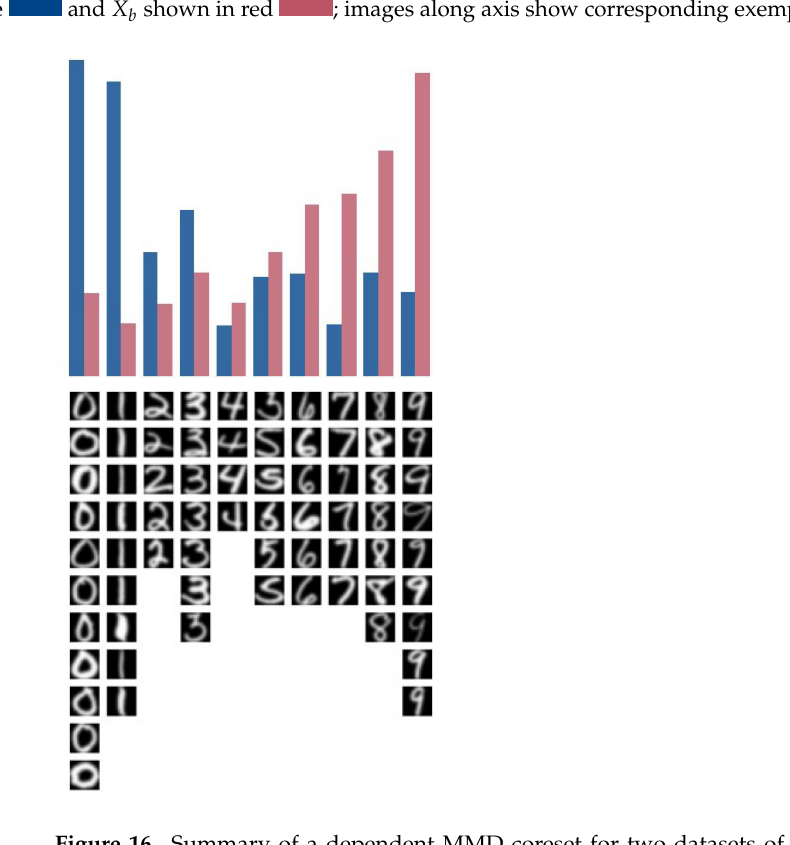
Figure 16. Summary of a dependent MMD coreset for two datasets of handwritten digits. The weights and exemplars from Figure 15 have been combined based on their label. Weights for X a are shown in blue and weights for X b are shown in red